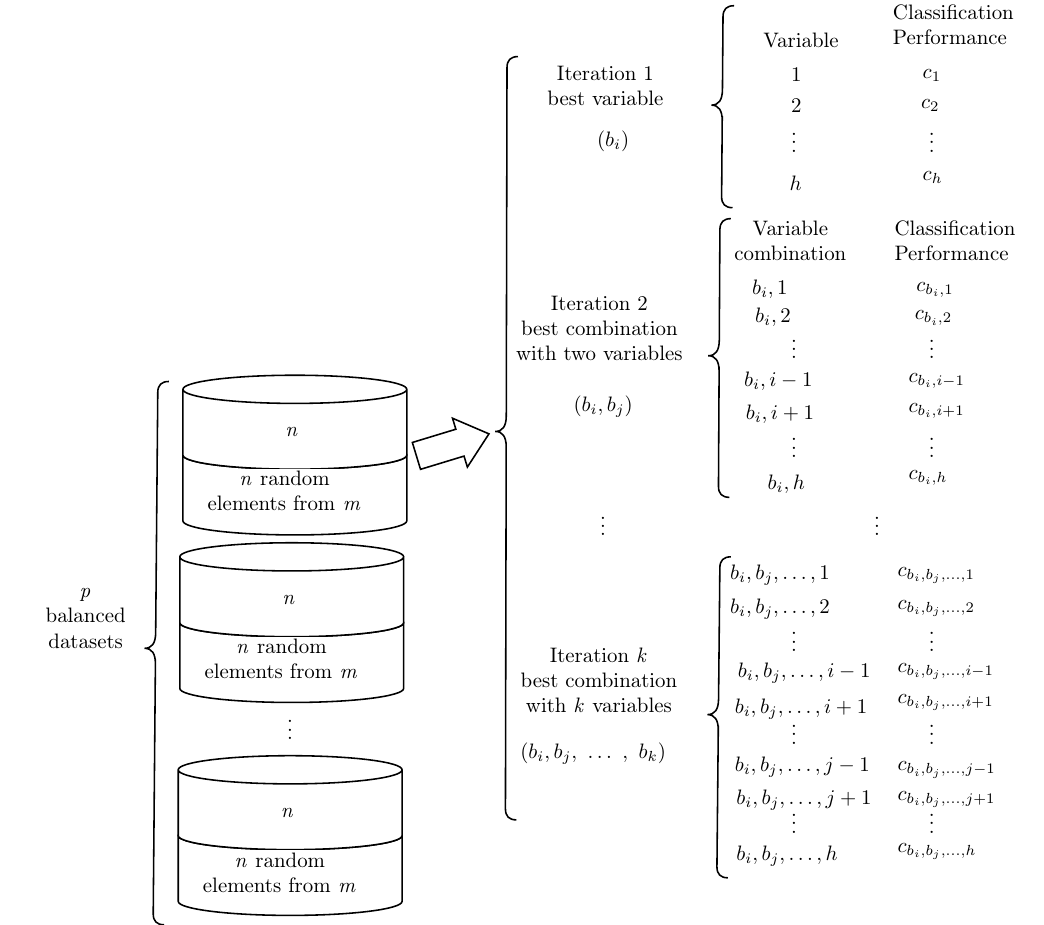
Figure 2: The process for defining the most relevant variables involves the search for the best combinations of variables including at most k -elements by using each balanced dataset. This search explores the interactions among variables and their impact on classification performance. A third step involved discovering the best k combinations for each p balanced dataset. As the discovery of a global optimum is not guaranteed, a reasonably good local optimum (based on classification performance) was used, as shown in Figure 4. Global optimums are not realistically feasible as the search space exponentially explodes with k